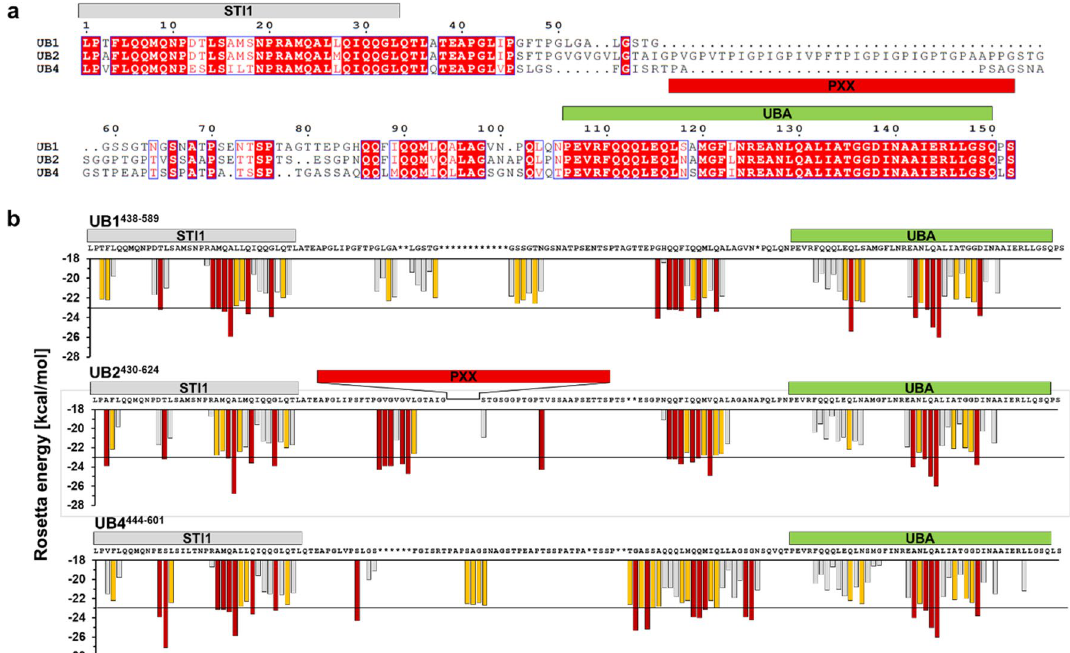
Figure 1. Sequence alignment and prediction of aggregation-prone regions of C-terminal ubiquilin constructs (UBQLN1 438–589 , UBQLN2 430–624 , and UBQLN4 444–601 ) used for in vitro studies. ( a ) The UBA domains